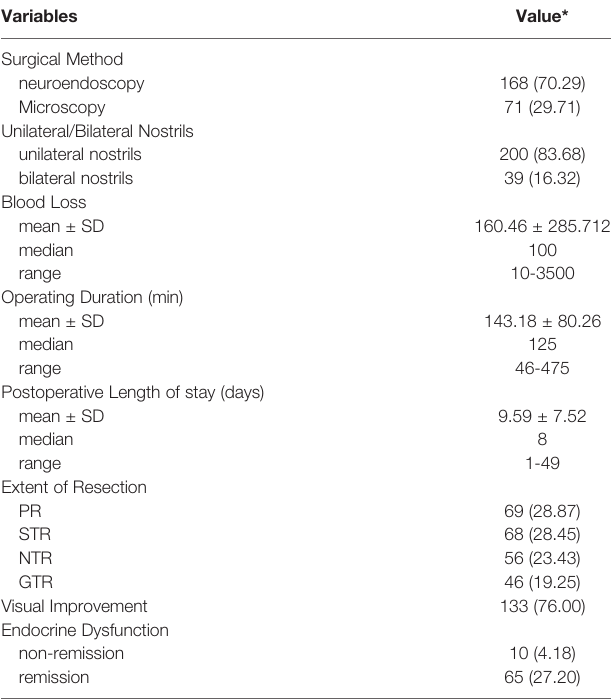
TABLE 4 | Surgical characteristics.